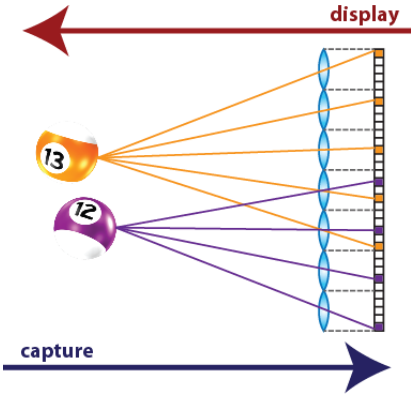
Figure 1. A 3D scene captured and displayed with IP technique. Note that, in the capturing stage, the observer is in the right side (behind the camera’s sensor), so he sees the violet ball closer. In the display stage, the observer is in the left side (in front of the MLA of the InI display), so he sees the orange ball closer: the scene is reconstructed with reversed